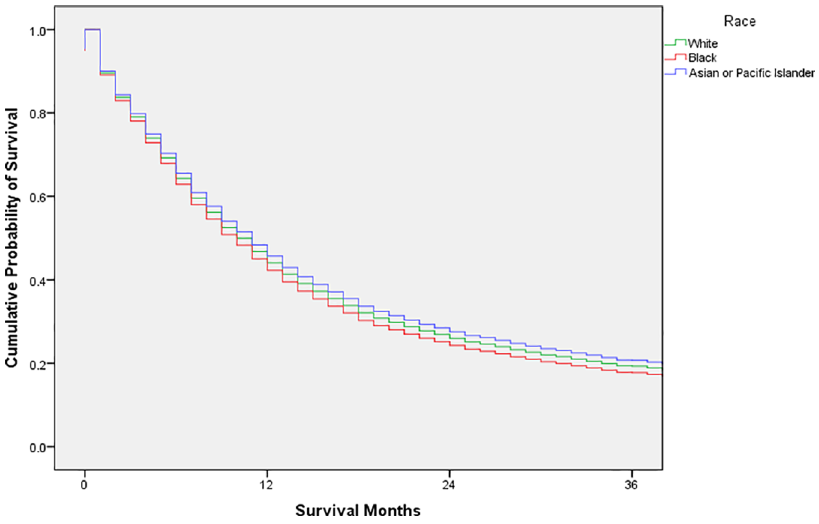
Fig 5. Adjusted survival curves, by race, for adult patients in the SEER database diagnosed with esophageal squamous cell carcinoma, 2000–2013.